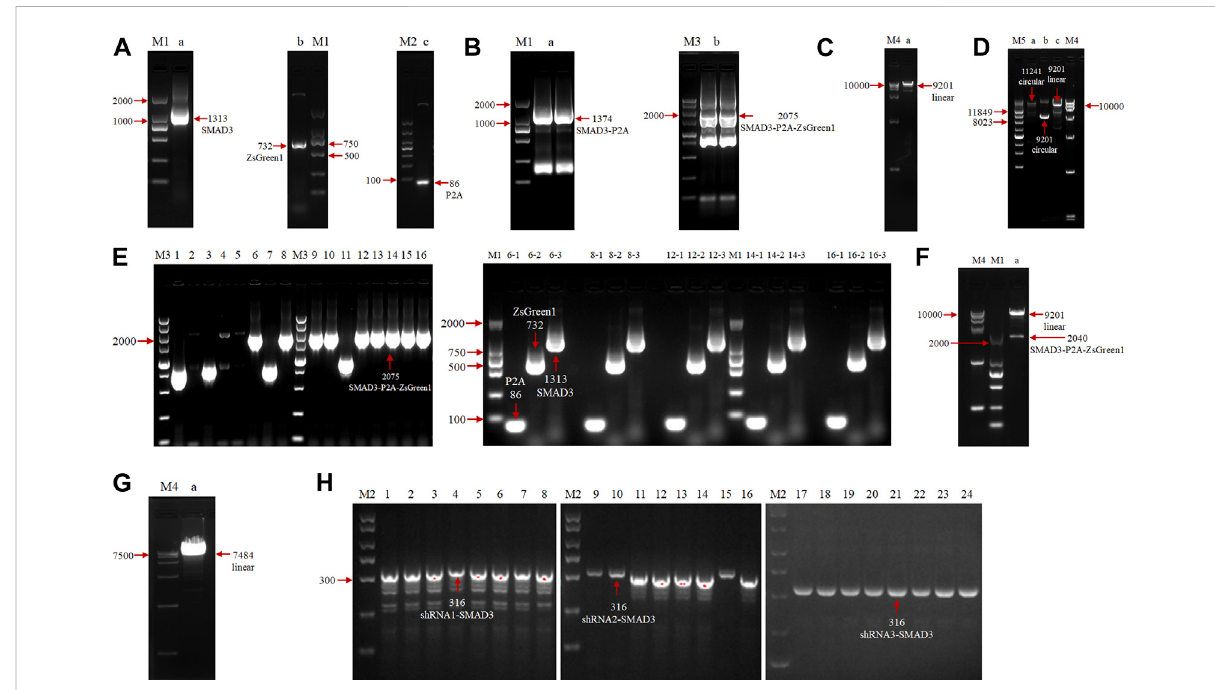
FIGURE 1 Agarose gel electrophoresisanalysisof overexpression and construction of eukaryotic expression vectors for theinterfering goat SMAD3 gene. (A) PCR ampli fi cation of SMAD3 , P2A, and ZsGreen1 sequences, respectively. M: marker (M1: DL2000, M2: DL1000); lane a: SMAD3 gene, 1313 bp; lane b: ZsGreen1 sequence, 732 bp; lane c: P2A sequence, 86 bp. (B) SOE PCR ligation of SMAD3 , P2A, and ZsGreen1 fragments. M: marker (M3: DL5000); lane a: SMAD3-P2A fragment, 1374 bp; lane b: SMAD3-P2A-ZsGreen1 fragment, 2075 bp (C) Enzymatic cleavage of the pLVX- TetOne-Purovector. M: marker (M4: DL15000); lanea: linearized pLVX-TetOne-Puro vector, 9201 bp. (D) Homologousrecombination reaction. M: marker (M5: Supercoiled DNA Ladder Marker); lane a: recombination product, 11241 bp; lane b: cyclic pLVX-TetOne-Puro vector, 9201 bp; lane c: linearized pLVX-TetOne-Puro vector, 9201 bp. (E) PCR identi fi cation of recombinant product transformed bacterial solution. Lanes 1 – 16: fi rst bacterial fl uid PCR bands of 16 monoclonal colonies, positive colony product (SMAD3-P2A-ZsGreen1) size 2075 bp; lanes 6/8/12/14/16 – 1/2/3: 6, 8, 12, 14, 16 positive colonies second bacterial fl uid PCR bands, positive colonies all can produce 86 bp (P2A), 732 bp (ZsGreen1) and 1313 bp ( SMAD3 ) bands, respectively. (F) Plasmid double digestion identi fi cation. Lane a: positive plasmids were digested by EcoRI and BamHI to become linearized pLVX-TetOne-Puro vector as well as SMAD3-P2A-ZsGreen1 bands (without homologous arms), size 9201 and 2040 bp, respectively. (G) Enzymatic cleavage of the pSicoR-Ef1a-mCherry vector. Lane a: linearized pSicoR-Ef1a-mCherry vector, 7484 bp. (H) PCR identi fi cation of ligated products transformed bacterial solution. Lanes 1 – 24: bacterial fl uid PCR bands of 8 monoclonal colonies each of 3 interfering target sequences, positive colonies products all 316 bp in size